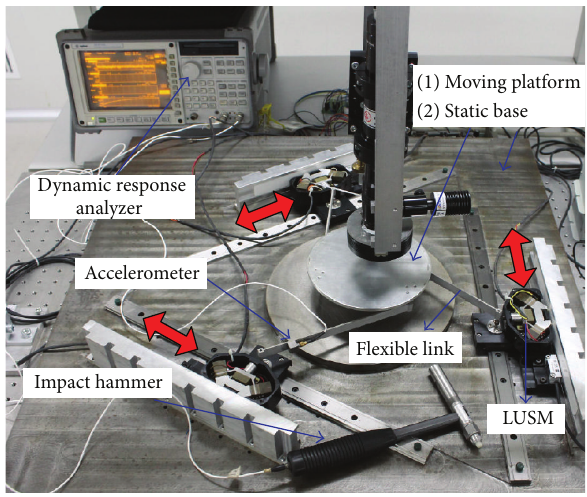
Figure 2: Photography of the modal test experiment